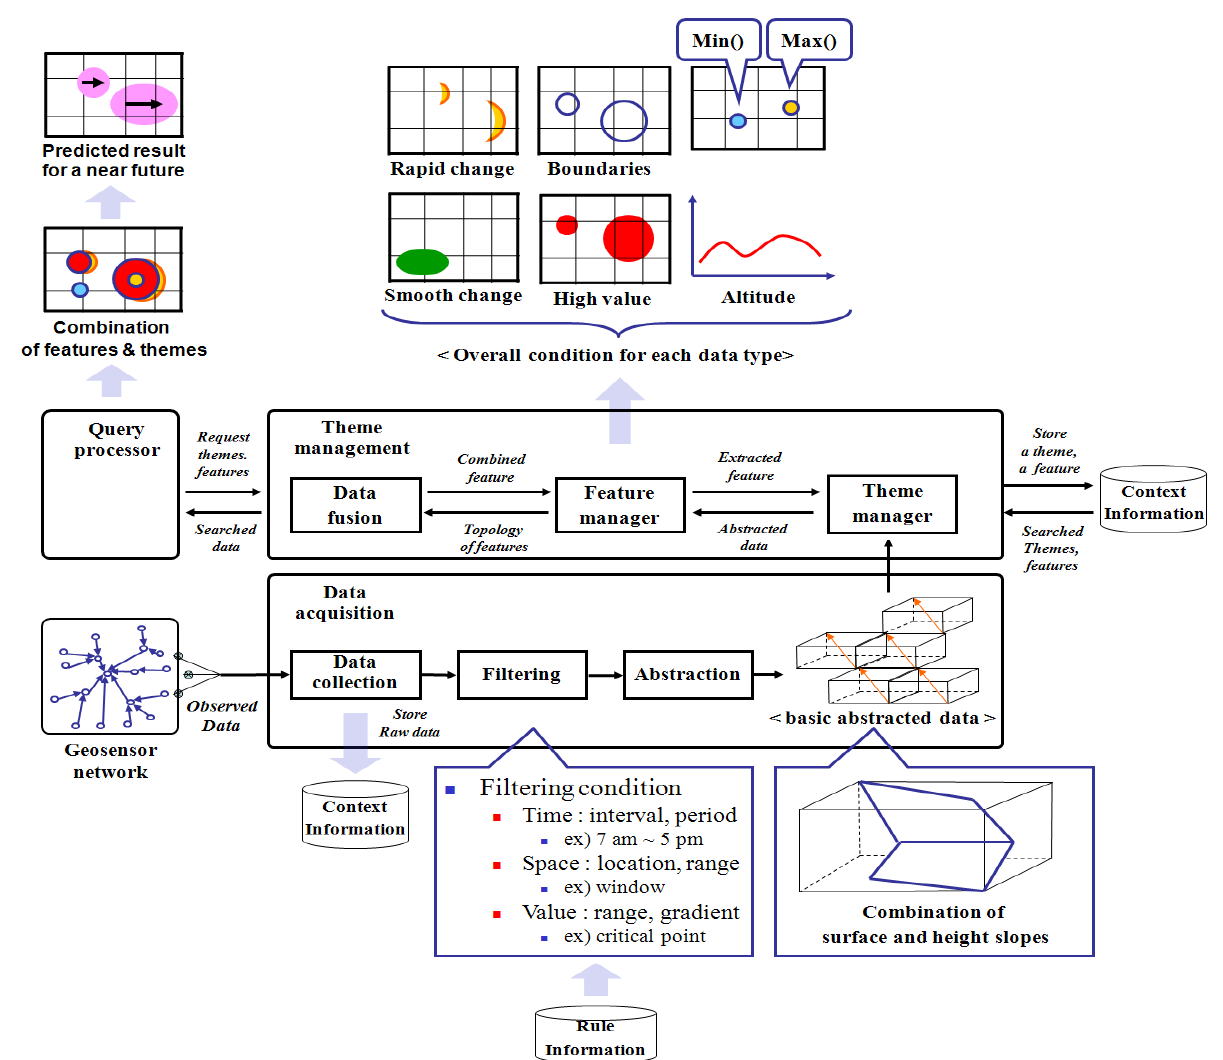
Figure 9. The data processing with abstracted sensor